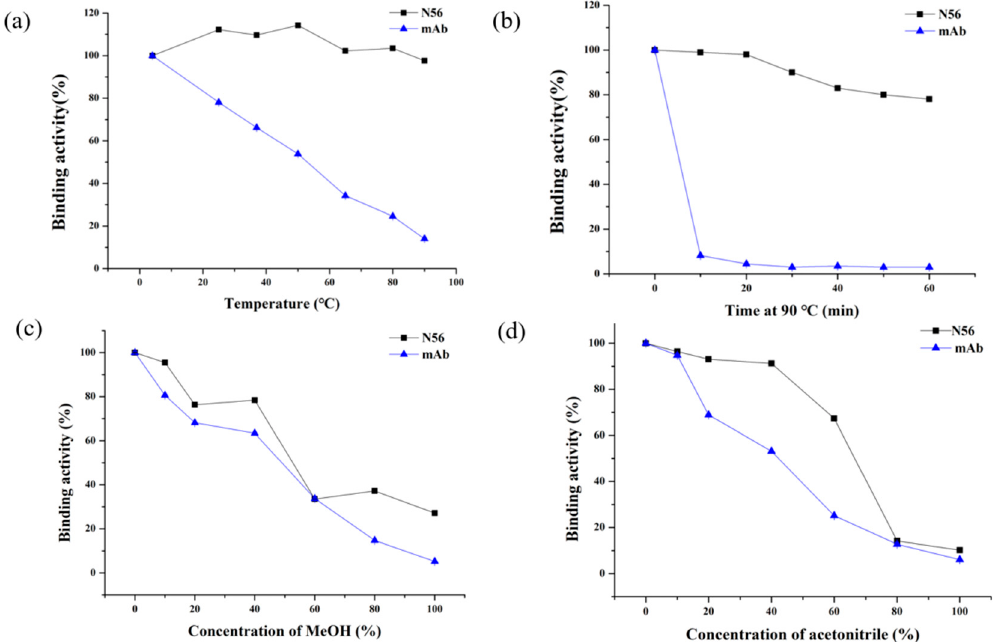
Figure 5. Thermostability and organic solvent tolerance of N56 and Mc-MAb by ic-ELISA: ( a ) N56 and Mc-MAb (1 mg/mL) were incubated at 25, 37, 50, 65, 80, and 90 ℃ for 10 min; ( b ) N56 and Mc-MAb (1 mg/mL) were incubated at 90 ℃ for 10, 20, 30, 40, 50, and 60 min; a series concentrations (10%, 20%, 30%, 40%, 50%, 60%, 70% and 80%) of ( c ) methanol (MeOH) and ( d ) acetonitrile were used to dilute ( v/v ) N56 and Mc-Mab ( n = 3).